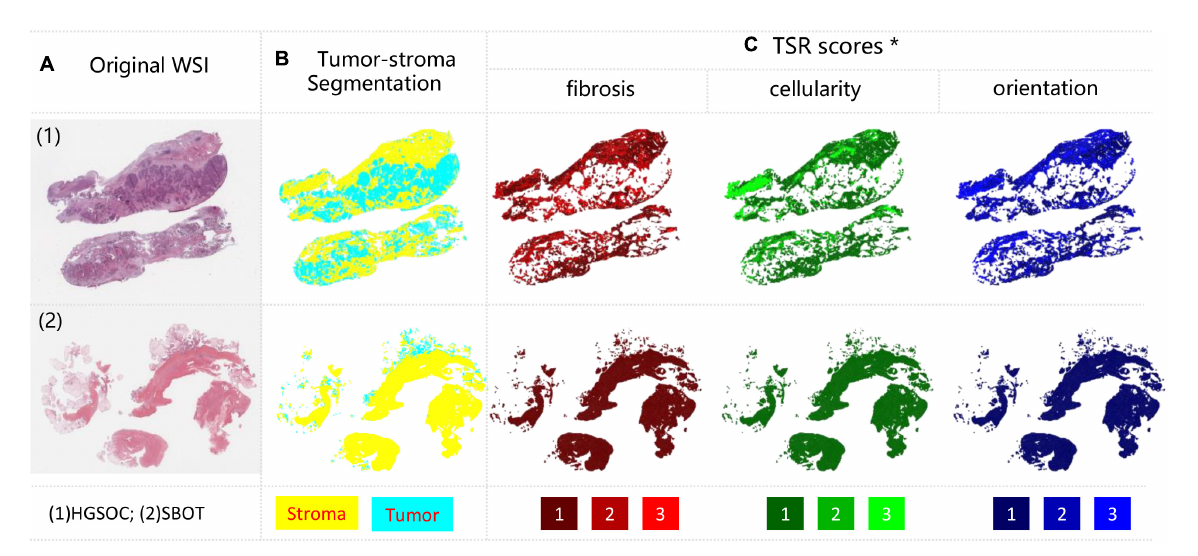
FIGURE2 Examples of tumor-stroma segmentation and TSR scoring results. (A) Original WSIs, with HGSOC and SBOT each; (B) tumor-stroma segmentation, tumor and stroma were encoded with cyan and yellow; (C) TSR scores measured from three metrics, including fibrosis (Red), cellularity (Green) and orientation (Blue). Each metric was encoded from dark to light color, denoting TSR score from low to high. *For better visualization, TSR scores within all stroma regions were shown, but only the tumor-stroma interface regions were included for